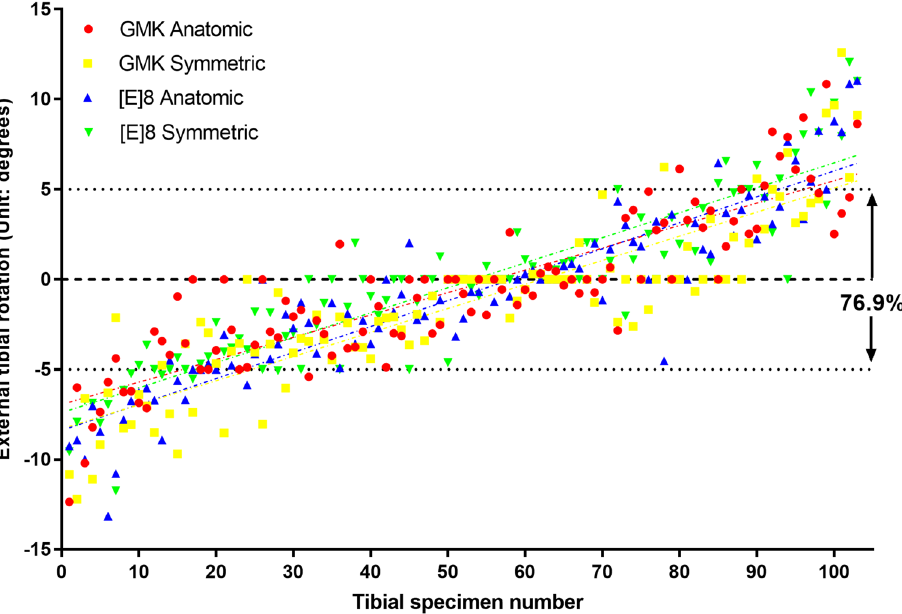
Figure 4. The degree of rotation for each specimen according to tibial component design when the Insall line was set as the reference axis with tibial rotation of 0°. The majority (76.9%) of the specimens were properly rotated within the ± 5°